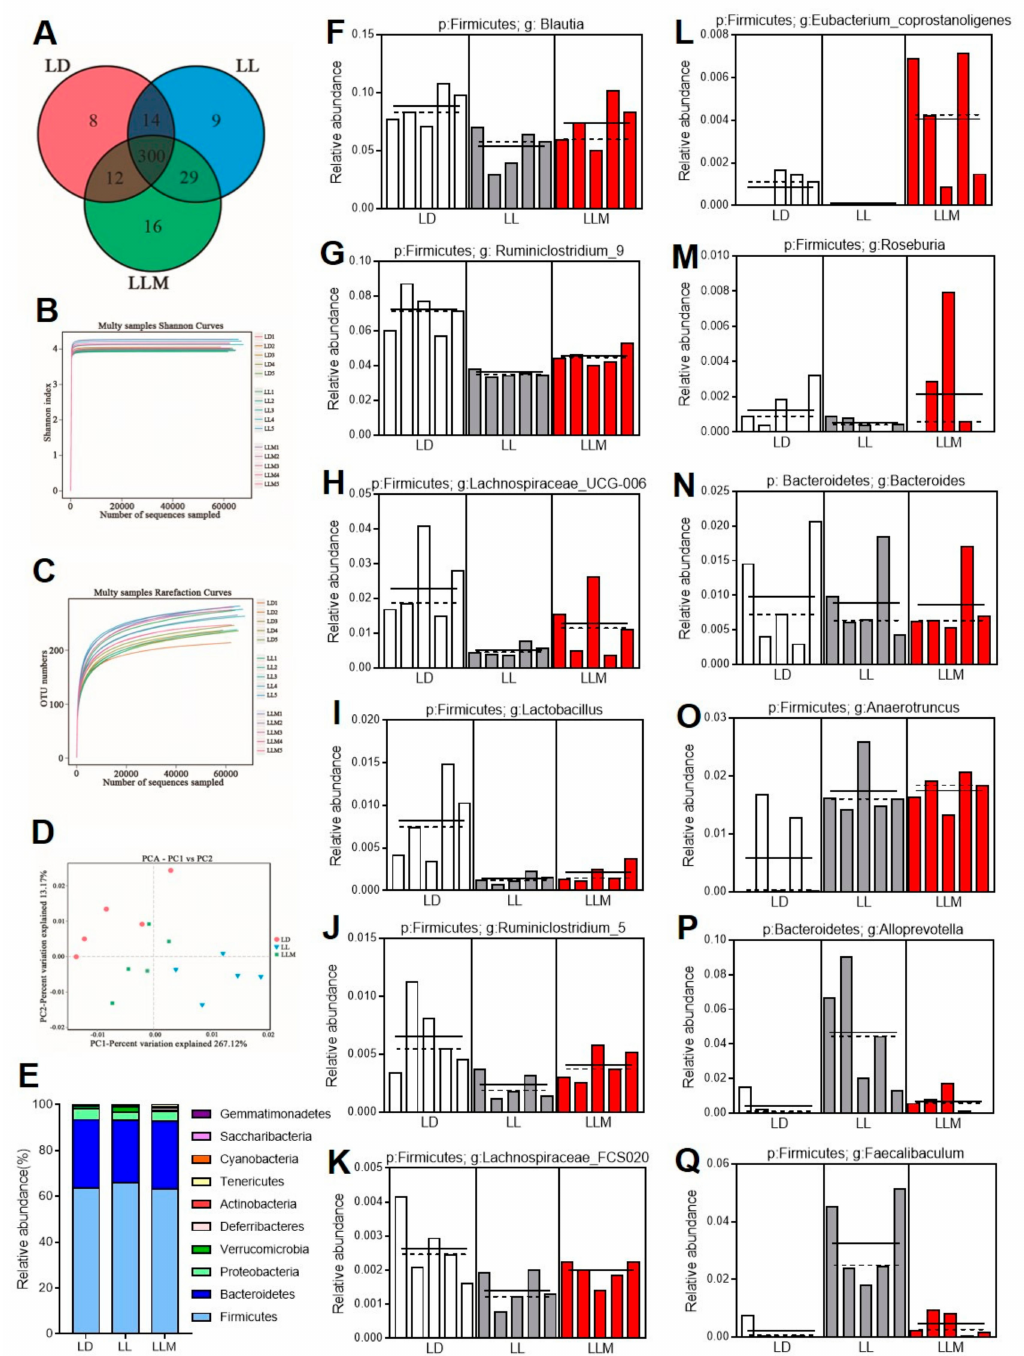
Figure 7. Melatonin improves the gut microbiota composition of HFD-fed mice with constant lighting. ( A ) Optical transform unit-Venn diagram (OTU-Venn), ( B ) Rarefaction curves, ( C ) Shannon curves, and ( D ) principal component analysis (PCA) of gut microbiota in the three groups. ( E ) Relative abundances of the gut microbiota at the phylum level. ( F – Q ) The relative abundance of Blautia , Ruminiclostridium_9 , Lachnospiraceae_UCG-006 , Lactobacillus , Ruminiclostridium_5 , Lachnospiraceae_FCS020 , Eubacterium_coprostanoligenes , Roseburia , Bacteroides , Anaerotruncus , Alloprevotella , and Faecalibaculum from the LEfSe results. N = 5, dotted line denotes median and solid line denotes